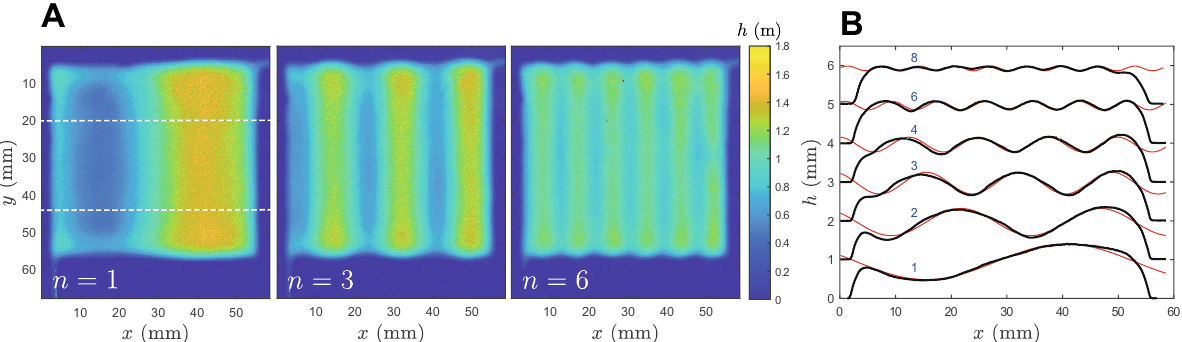
Figure 5. ( A ) Thickness gradient were obtained with a variation of overlap distance δ at constant flow rate and deposition velocity: here, a sinusoidal pattern has been imposed with a constant average height (1 mm) and fluctuation magnitude (0.5 mm); the number of periods (cid:31) can be varied along the writing distance L and is L / (cid:31) ; the dashed lines show the zone where the profiles have been averaged to obtain part characterized by n = ( B ) where the index n is given for each curve (which are systematically shifted by 1 mm for the sake of